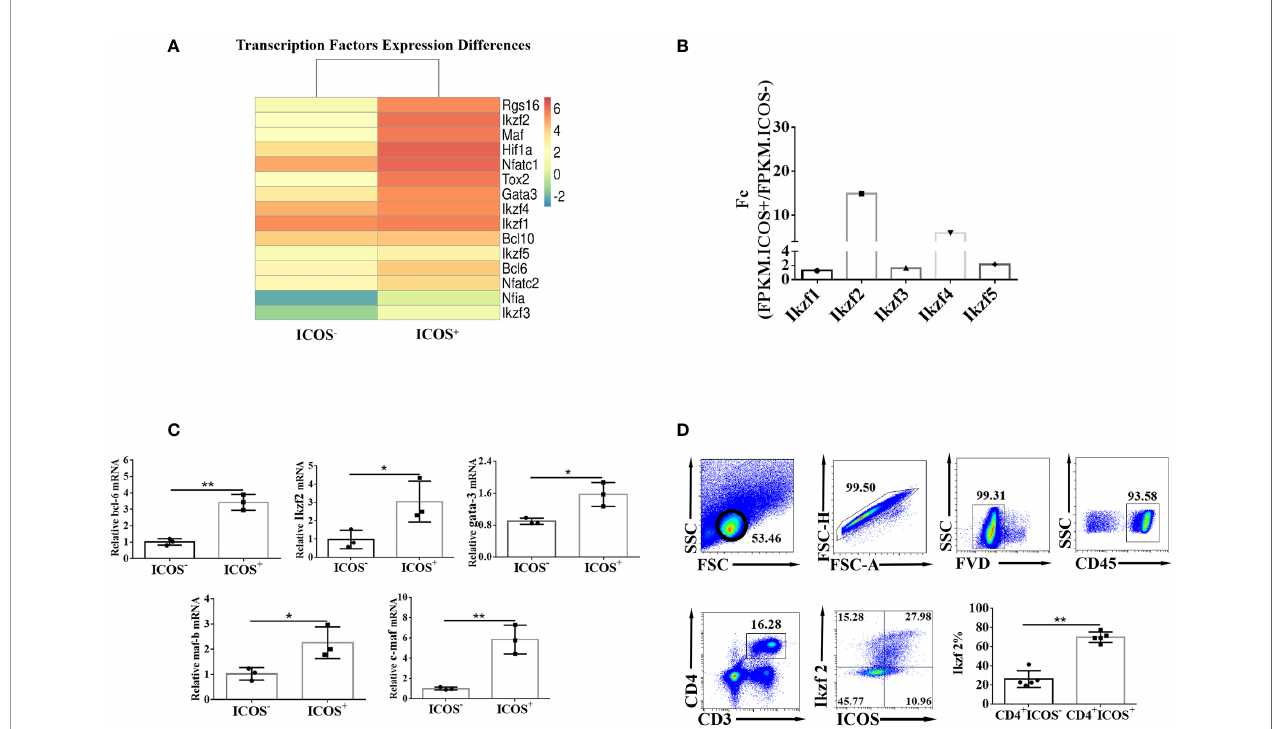
FIGURE 4 | Transcription factor Ikzf2 is highly expressed in ICOS + Th cells. (A) The expressions of ICOS activation- and function-related transcription factors in ICOS − /+ Th cells detected by mRNA sequencing were compared. (B) ICOS activation function-related transcription factor differences were detected by qRT-PCR. (C) The comparison of the expression of Ikzf2 family members in CD4 + ICOS + and CD4 + ICOS − groups. FC (fold change) was the result after FPKM.ICOS + / FPKM.ICOS − . Differential genes were selected based on FC ≥ 2, or ≤ 0.5, and P < 0.05. (D) The expression difference of Ikzf2 in CD4 + ICOS − /+ Th cells was detected by fl ow cytometry. All the doublet cells, dead cells, and nonlymphoid cells were excluded from fl ow cytometry data. Data are shown as three samples in each group from one representative experiment, and experiments were repeated three times with similar results. * P < 0.05, ** P <